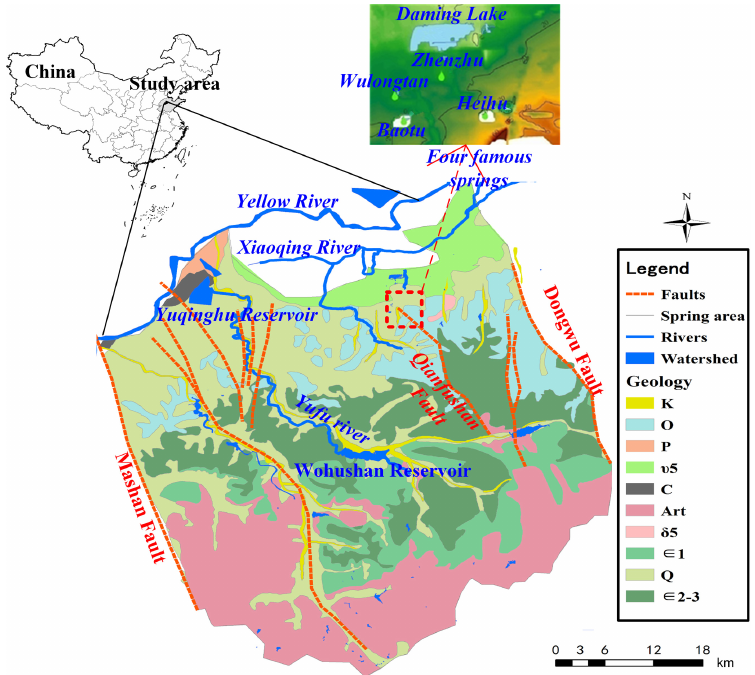
Figure 1. Map of the study area.